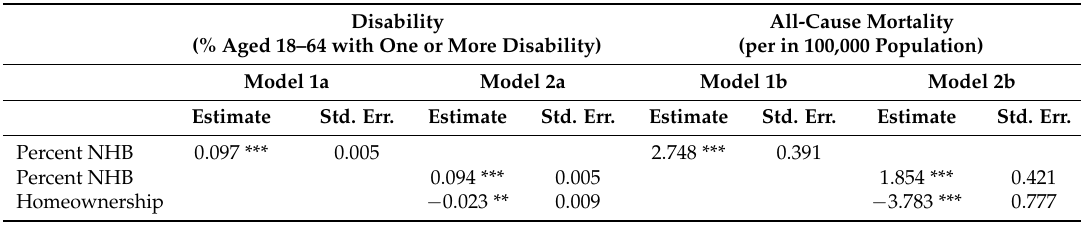
Table 2. Neighborhood level disability and all-cause mortality regressed on percent NHB (Models 1a and 1b), and homeownership (Models 2a and 2b).